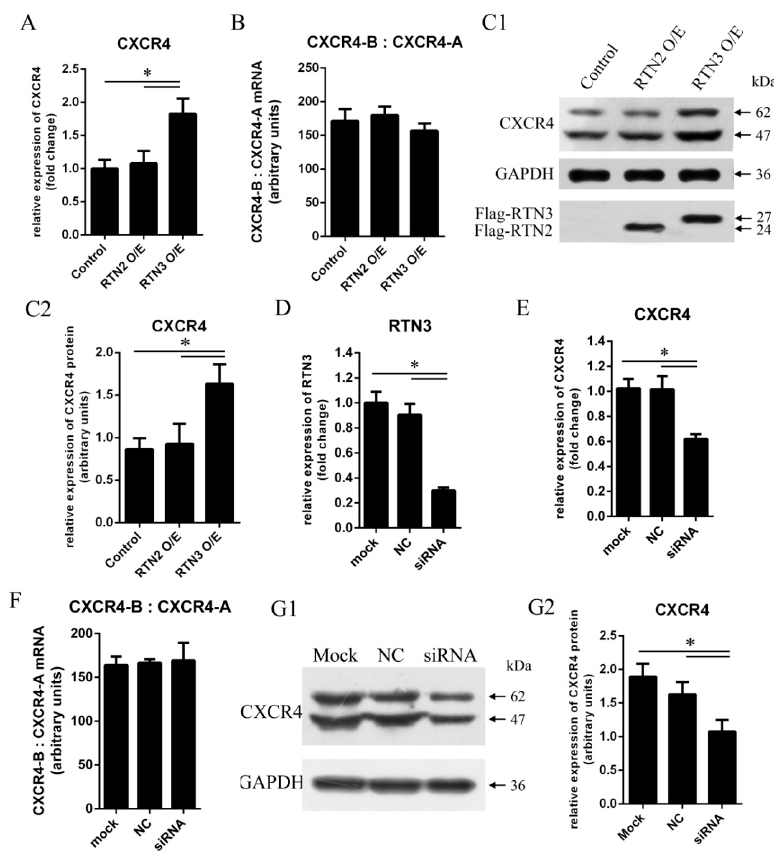
Figure 2. CXCR4 expression levels are elevated by RTN3 overexpression and suppressed by RTN3 deficiency. ( A , C1 , C2 , E , G1 , G2 ) Endogenous CXCR4 mRNA and protein expression in HEK293 cells. Endogenous CXCR4 or GAPDH mRNA and protein levels were monitored by real ‐ time PCR and Wwestern blotting. C2 and G2 show quantitative analyses of the grayscale band intensity of the western blots. ( B , F ) Relative expression of the CXCR4 ‐ B and CXCR4 ‐ A mRNA isoforms. The ratio between CXCR4 ‐ B and CXCR4 ‐ A mRNAs was detected by real ‐ time PCR in HEK293 cells when the RTN3 expression level was changed. ( D ) RTN3 knockdown in HEK293 cells. Small interfering RNAs (siRNAs) targeting RTN3 were transfected into HEK293 cells for 48 h, and endogenous RTN3 mRNA as detected by real ‐ time PCR to determine the efficiency of RTN3 knockdown. Data represent the mean ± SEM from three wells per group. * p < 0.05. Results are representative of three independent experiments.